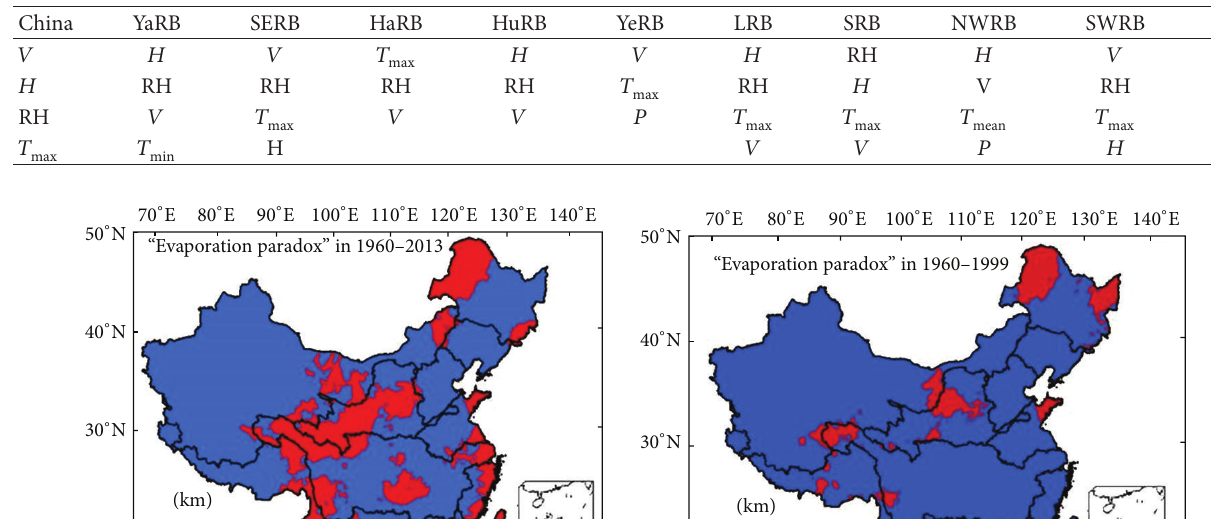
Table 2: Results of the stepwise regression.